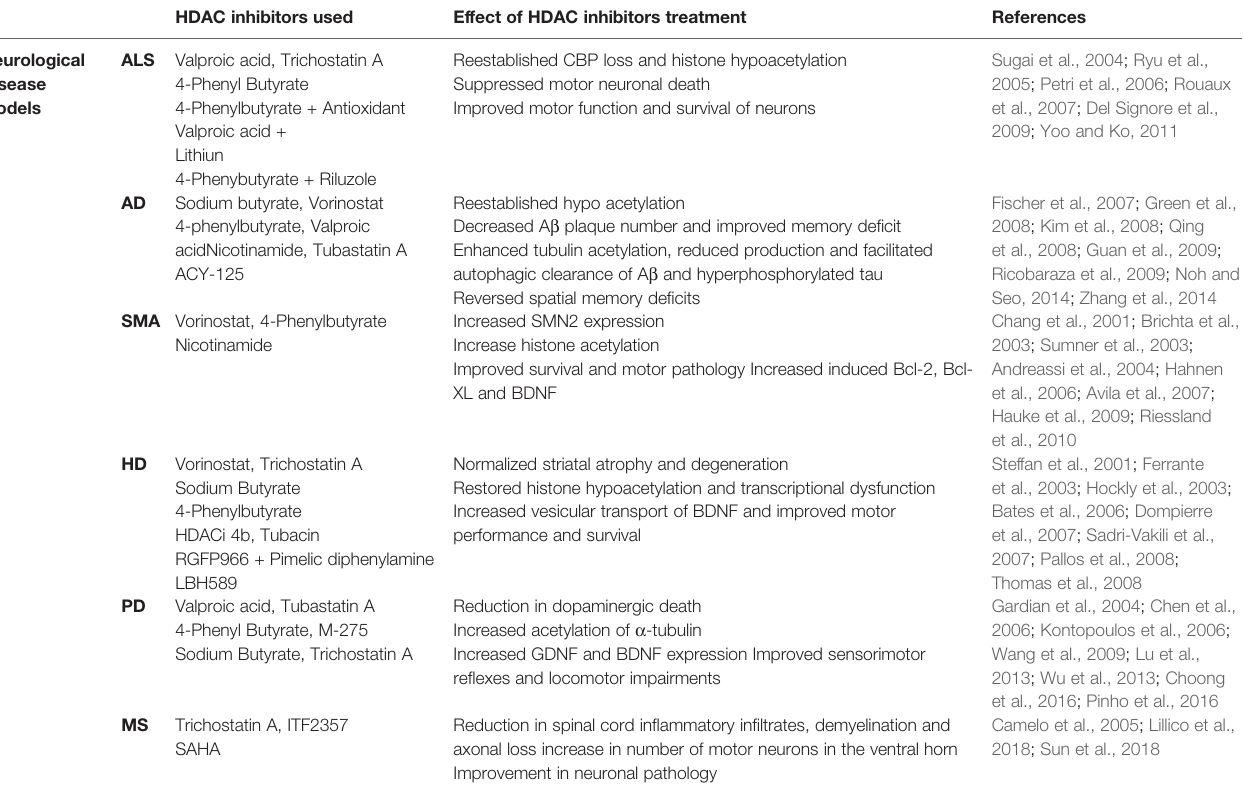
TABLE 2 | HDAC Inhibitors used in neurodegenerative disease models and their